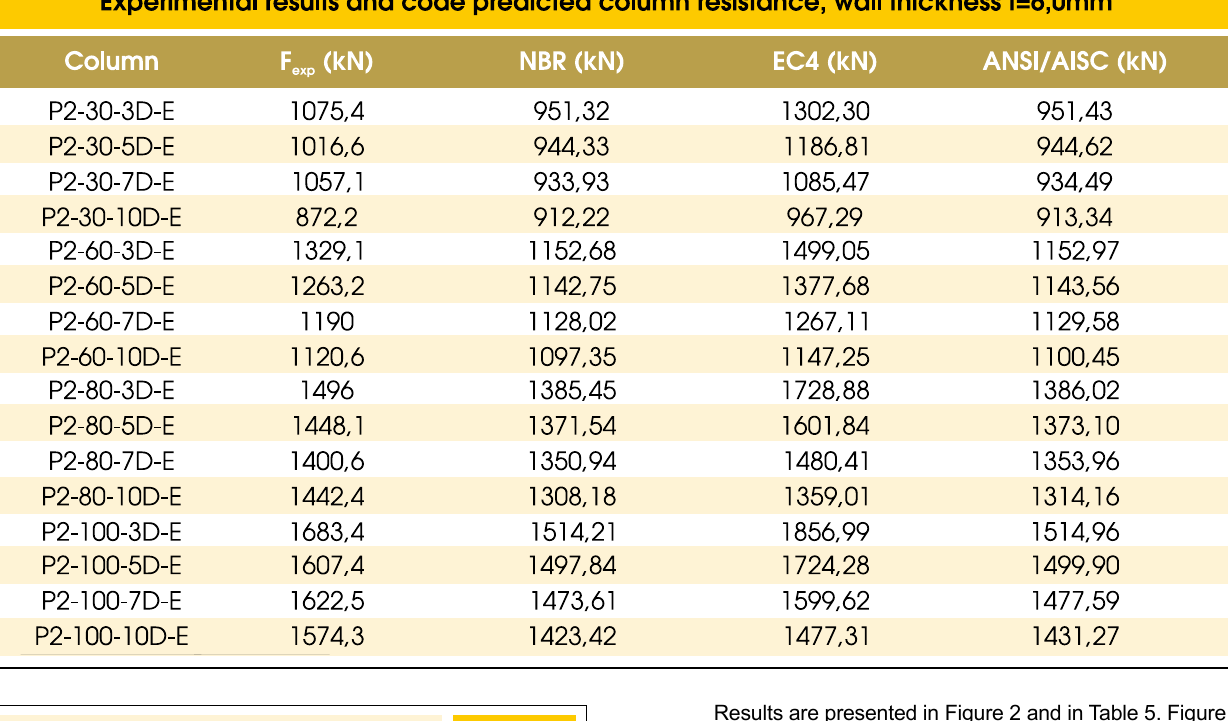
where σ and σ are the standard deviation of variables x and y, respec - x y tively, and cov(x,y) is the covariance operator. A near zero correlation index indicates that there is no linear tendency between the variables.